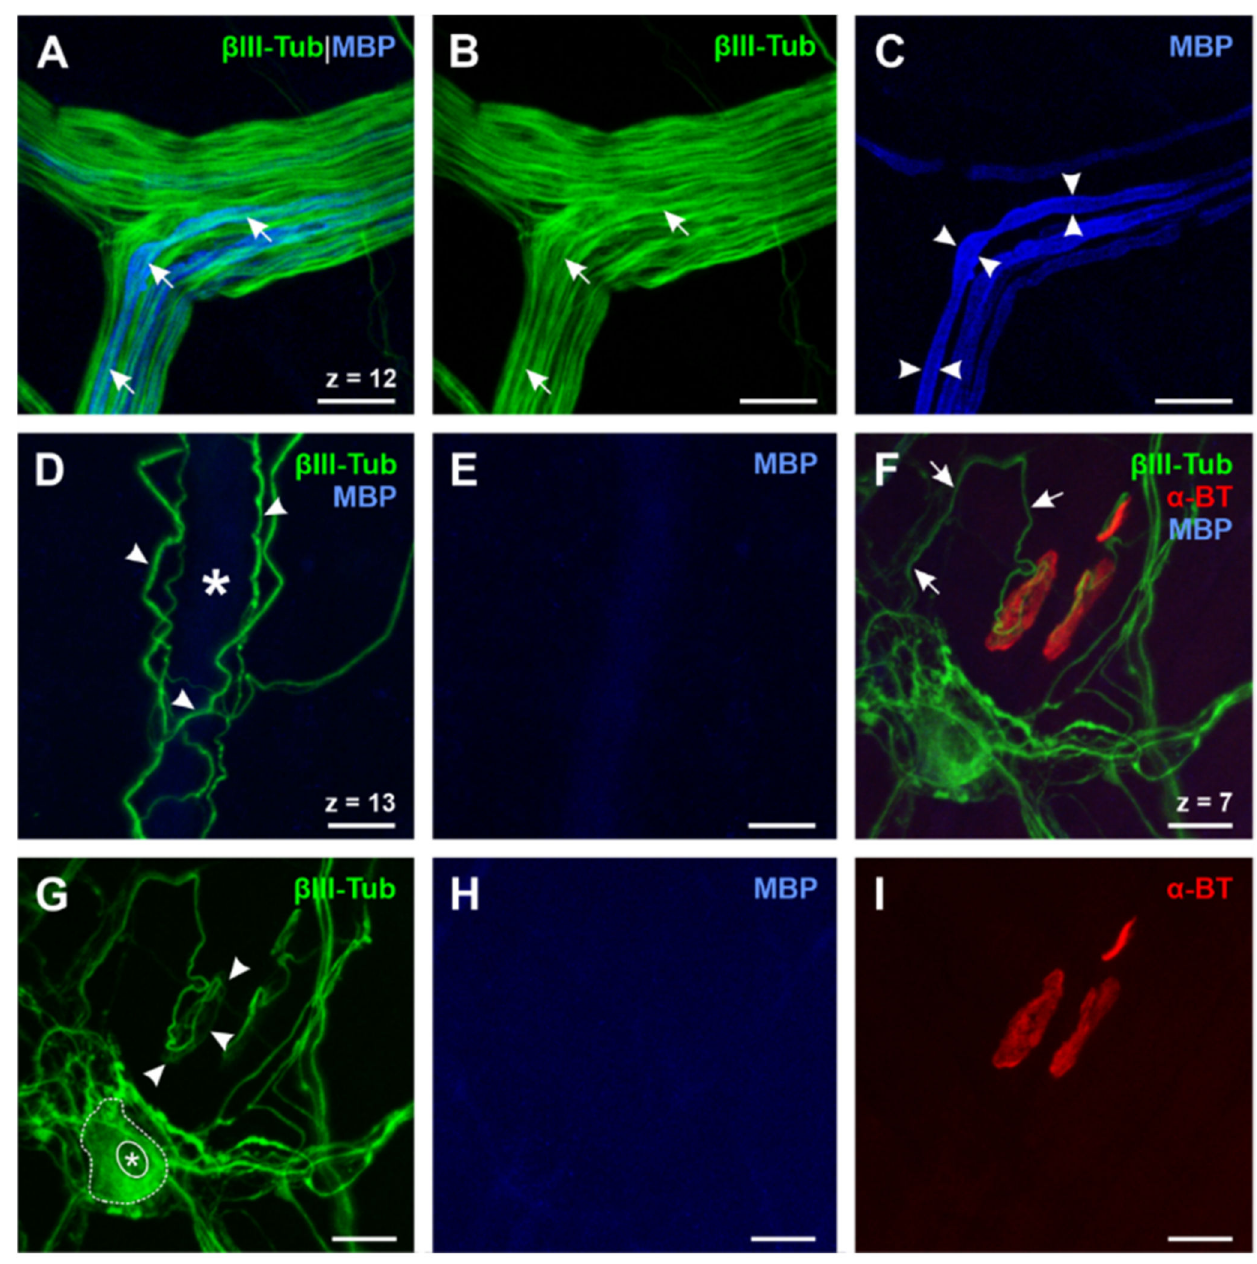
Figure 3. Expression of β III-Tubulin, MBP, and α -BT in the esophagus ( A )–( E ): Triple whole mount staining of β III-tubulin, MBP, and α -BT ( α -BT not shown, N ◦ 5 (cid:13) , Table 2). Axons (( A ) and ( B ), short arrows) of peripheral vagal nerve branches are only partially myelinated ( C , arrowheads), while gracile blood vessel-related nerve fibers, which are tightly wrapped around the outer vessel wall, appear β III-tubulin-positive ( D , arrowheads) but always lack myelin since no MBP signal can be detected ( E ). The lumen of the blood vessel is marked by the asterisk ( D ). ( F )–( I ): Triple whole mount staining of β III-tubulin, MBP and α -BT (N ◦ 5 (cid:13) , Table 2) reveals that endplate contacting efferent axons ( F , short arrows) are always unmyelinated for a long distance ( H ) and form a framework in the presynaptic region of the NMJ ( G , arrowheads). These findings confirm the results of the ChAT staining protocol (cf. Figure 2E–H). Moreover, β III-tubulin can also be found in enteric neurons ( G , dotted line; nucleus marked by asterisk) of the myenteric plexus and therefore proves to be a suitable neuro-axonal marker for the evaluation of the ENS in the esophagus. ChAT: Cholin acetyltransferase; MBP: Myelin basic protein; Z-step = 1 µ m; scale bars 20 µ